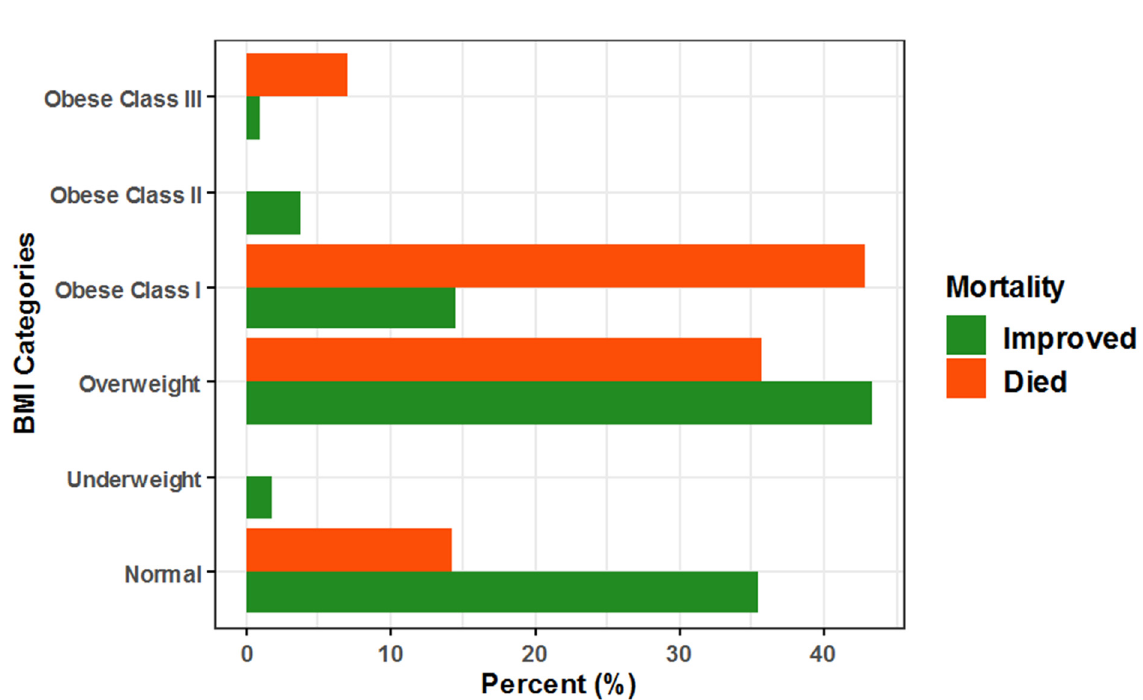
Figure 2. Association between BMI and disease mortality among hospitalized COVID ‐ 19 patients. Table 3. Relationship between patient BMI and mortality due to COVID ‐ 19.